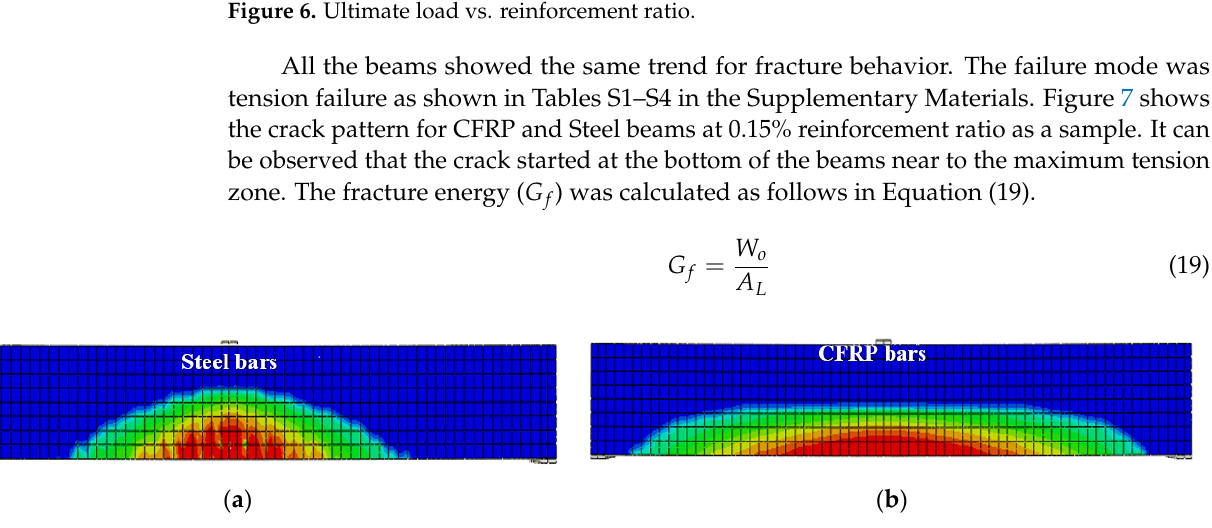
Figure 7. Crack Pattern at 0.15% reinforcement ratio ( a ) Steel and ( b ) CFRP beams.